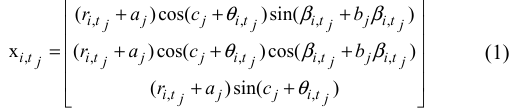
(Figure 3a). This incorporates multiple feature types with the goal of decreasing correlation between parameters and increasing overall accuracy. ii) The sensor-package is placed at various locations/orientations in the test-field (Figure 3b). Images and lidar data are recorded at each location increasing the variations in orientations and, thus, strengthening the geometric network. iii) An additional network of images is acquired using a previously calibrated camera (Canon M5) at each location such that the IMU board can be imaged with high resolution as well (Figure 3c). These observations are used to define the position and orientation of the IMU-body frame w.r.t the mapping coordinate system, as well ad estimating the 3D coordinates of the targets placed on the primitive geometric features. iv) A multi-sensor, integrated, controlled bundle adjustment is performed. The observations include lidar range and encoder angle measurements over the planar and cylindrical, image observations of target points installed on the features, and image observations of the IMU body-frame (centre, a point along x- axis, a point along y-axis). The unknowns are the intrinsic calibration parameters of the lasers ( a j , b j , and c j for j=1,..,16), the relative orientation (RO) of the lidar sensor to the camera ( ω L , φ L , κ L , T L ), the relative orientation of the IMU to the camera ( ω I , φ I , κ I , T I ), the EOPs of the cameras in each location ( ω t , φ t , κ t , C t ), and the parameters of the test field features. Given the strong geometry of the network, these parameters are all simultaneously